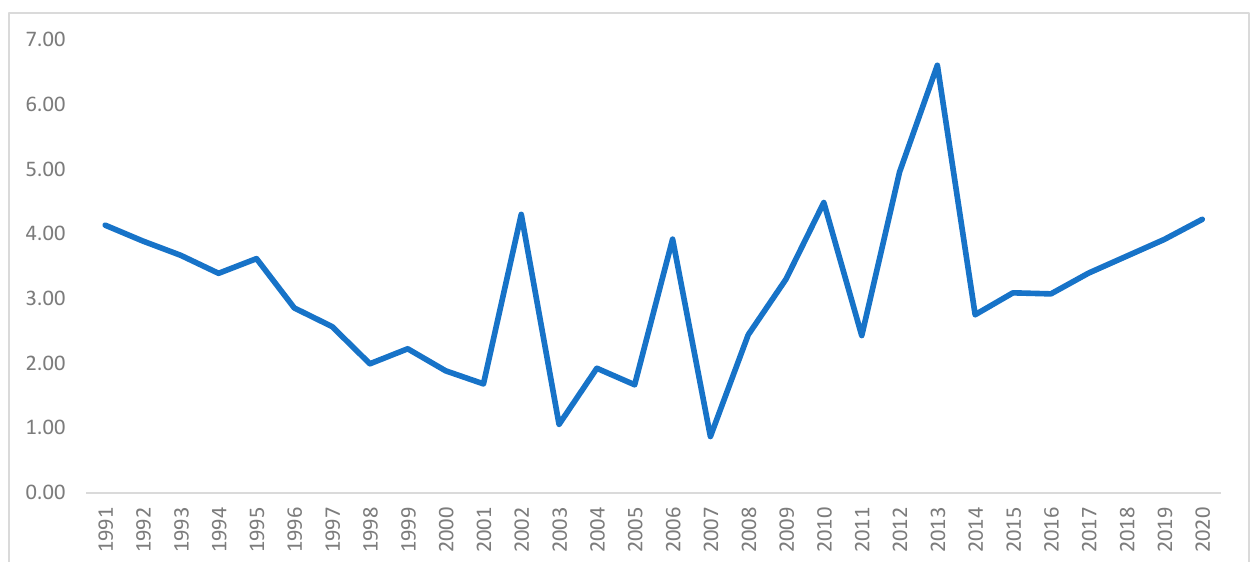
Figure 8. Environment and sustainability index and sub-indices.